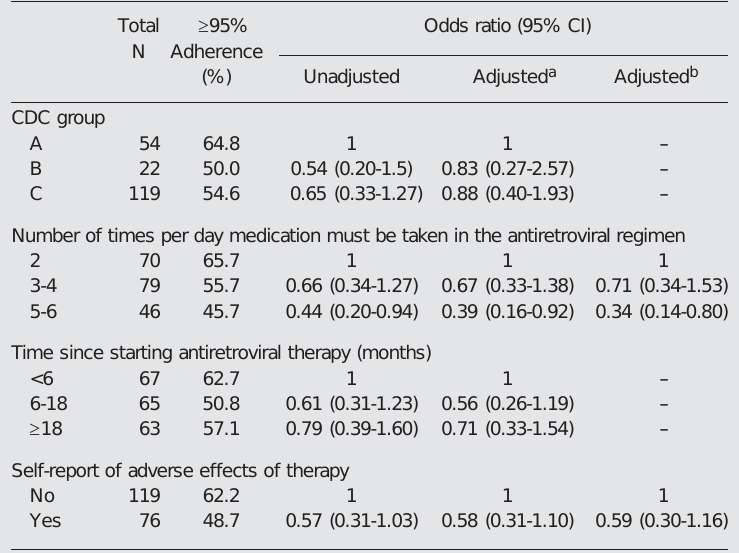
Table 4. Sociocognitive variables for antiretroviral therapy - nonadherent vs adherent patients.